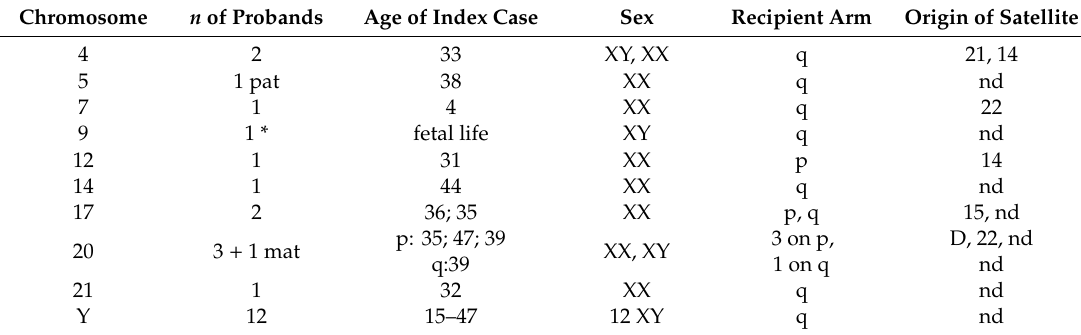
Table 2. Summary of